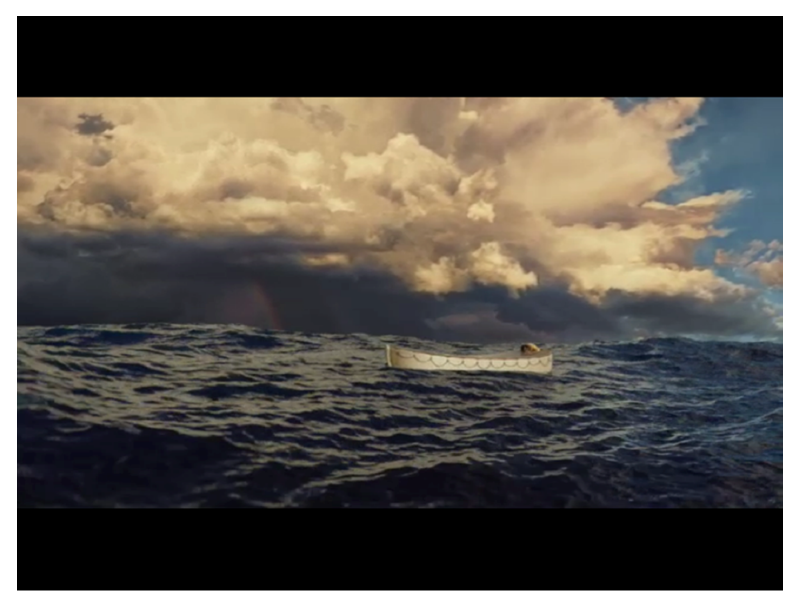
Figure 13. Skies were digitally matched with CGI water to illustrate Pi’s moods.